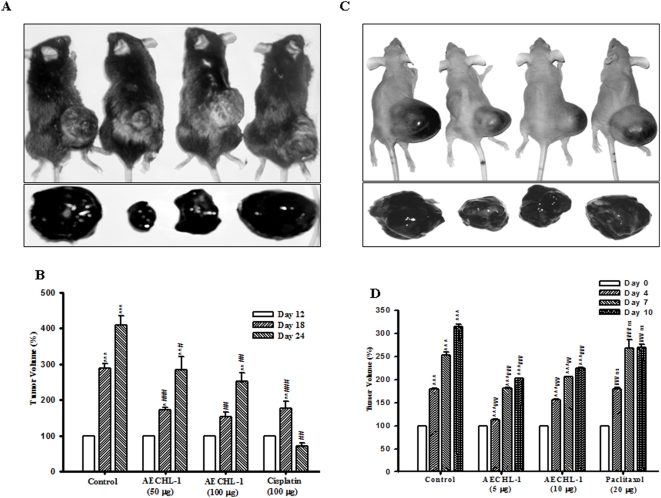
Effect of AECHL-1 on primary tumor volume in allograft and xenograft.(A) Photographs of C57BL/6 mice showing 4-week-old allograft tumor growth
by B16F10 cells; below, excised tumors with respective
mice; (B) Tumor volume was determined at timed intervals as described in
“Materials and
Methods”. Tumor volume of experimental animals after
treatment with 50, 100 µg AECHL-1 and 100 µg
cisplatin was compared with the tumor volume of control animals; (C)
Photographs of athymic nude mice showing 4-week-old xenograft tumor
growth by MCF-7 cells; below, excised tumors with
respective mice; (D) Tumor volume of experimental animals after
treatment with 5, 10 µg AECHL-1 and 20 µg paclitaxel
was compared with the tumor volume of control animals. Results represent
the mean±SE of six starting animals in each group.
Significant differences between *Intra group at each
time point are represented as: ns p>0.05,
*p<0.05,
**P<0.01,
***P<0.001 and
#Inter group at different doses are represented as
ns P>0.05, #<0.05,
##P<0.01, ###P<0.001.